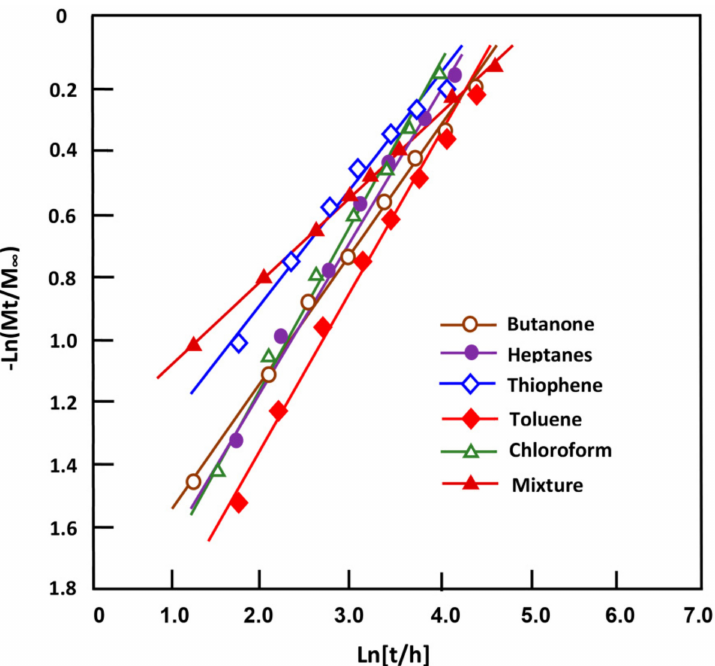
(cid:16) (cid:17) w t − w o vs. Ln ( t ) for the swelling of the SILI- w ∞ − w o